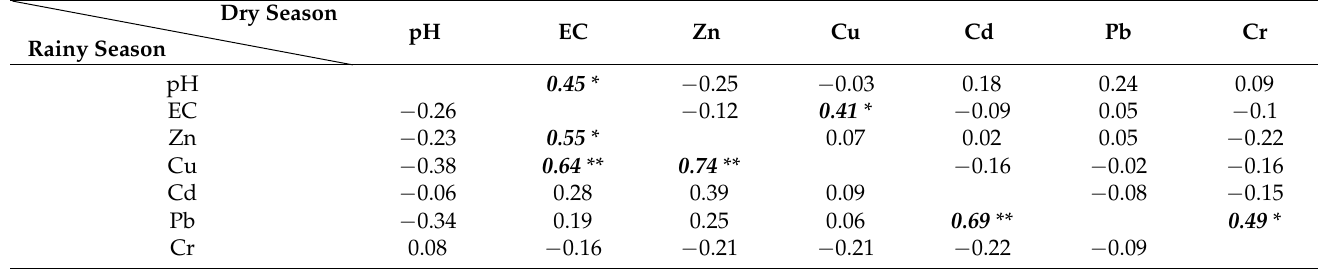
Table 4. Pearson correlation matrix of pH, EC values, and heavy metal concentrations in the Fuhe River